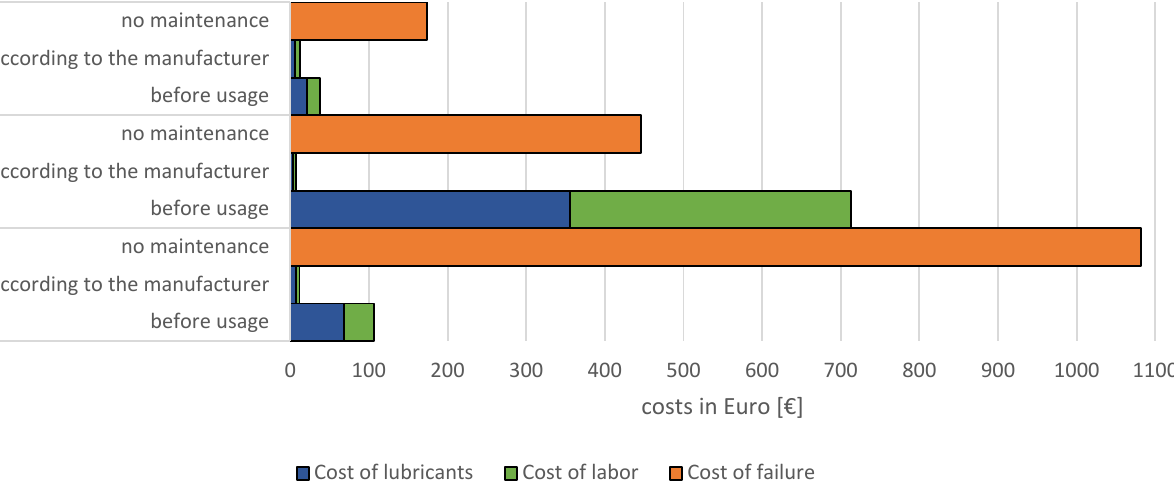
Figure 6. Results of the total annual cost calculation for the large baler, the feed mixer, and the manure tank in Euro (€).